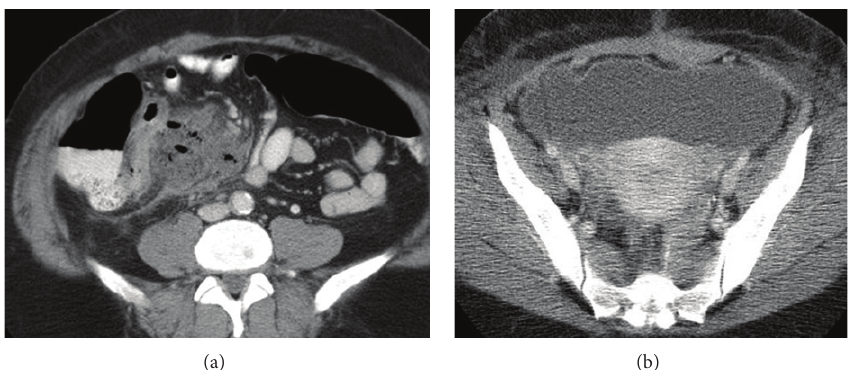
Figure 1: (a) Demonstrates an abdominal abscess on the right side of the abdomen following a right hemicolectomy. (b) Demonstrates a large pelvic abscess from a leaking anastomosis following a rectosigmoid